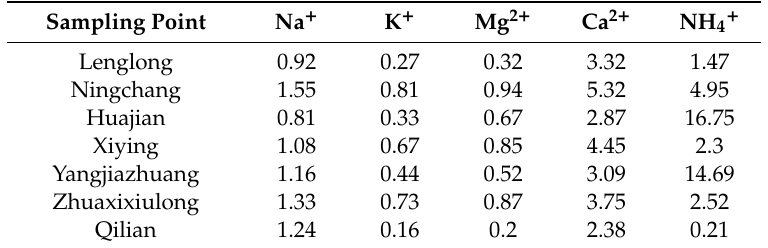
Table 4. Neutralization factor (NF) of cations at di ff erent sampling points.